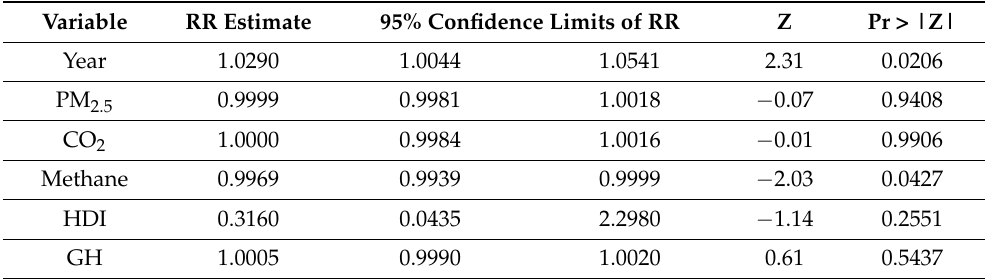
Table 4. Regression model estimates for each pollutant controlling for yearly trend. Parameter RR Estimate 95% Confidence Limits of RR Z Pr > |Z| PM 2.5 0.9997 0.9986 1.0009 − 0.50 0.6190 CO 2 1.0006 0.999 1.0023 0.73 0.4644 Methane 0.9979 0.9953 1.0005 − 1.55 0.1207 HDI 0.5158 0.0349 7.6162 − 0.48 0.6298 GH 0.9997 0.9979 1.0016 − 0.27 0.7879